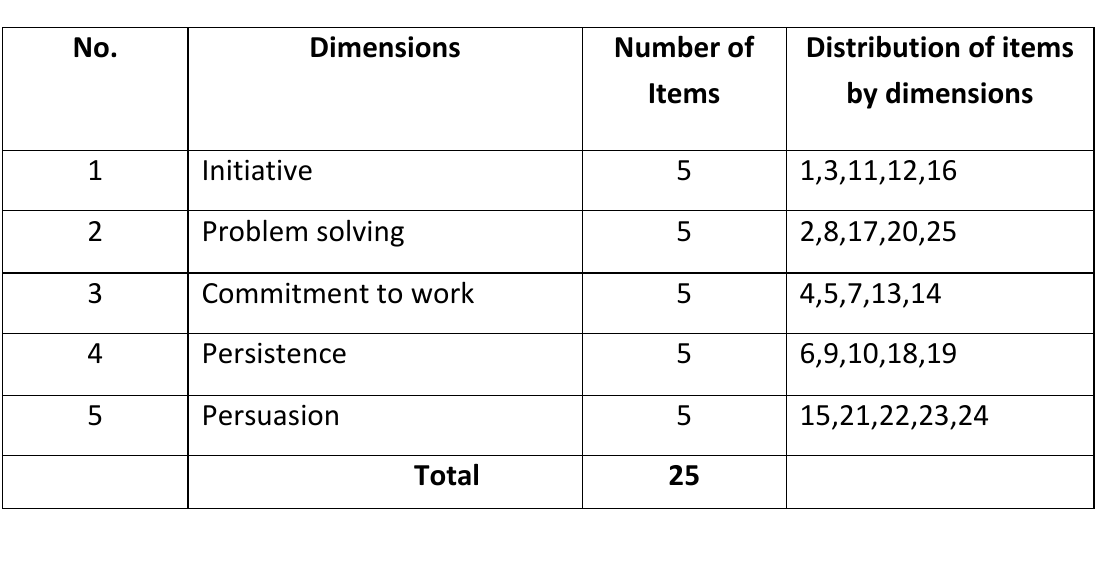
Table 2: Dimensions and distribution of items in the Attitude of Teacher Trainees towards Entrepreneurial Education